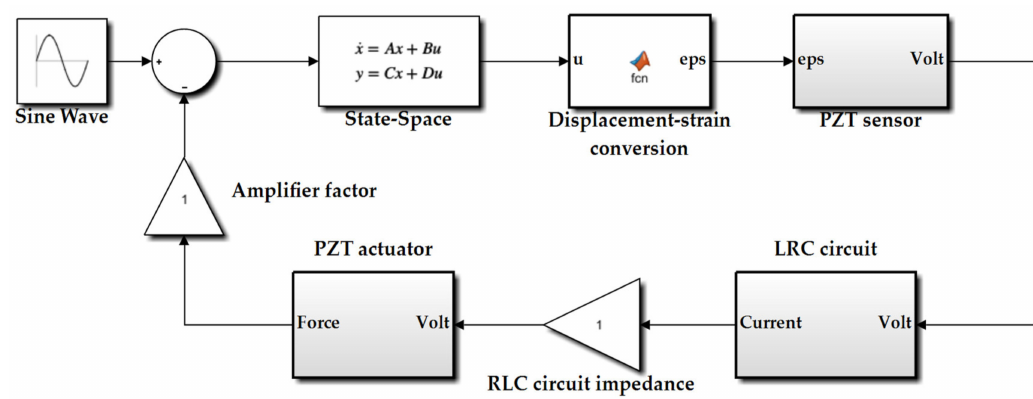
Figure 6. Closed loop Simulink ® model.